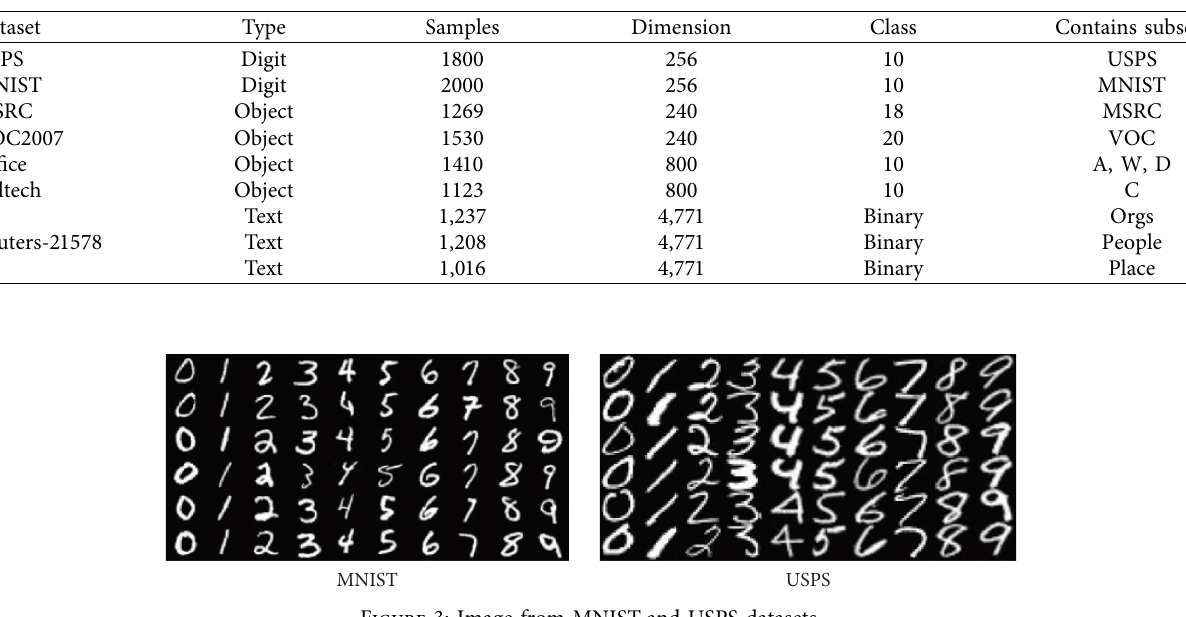
6 categories of the two datasets, including aircraft, birds, cows, family cars, sheep, and bicycles. Ten, we construct two transfer learning tasks: MSRC vs. VOC and VOC vs.